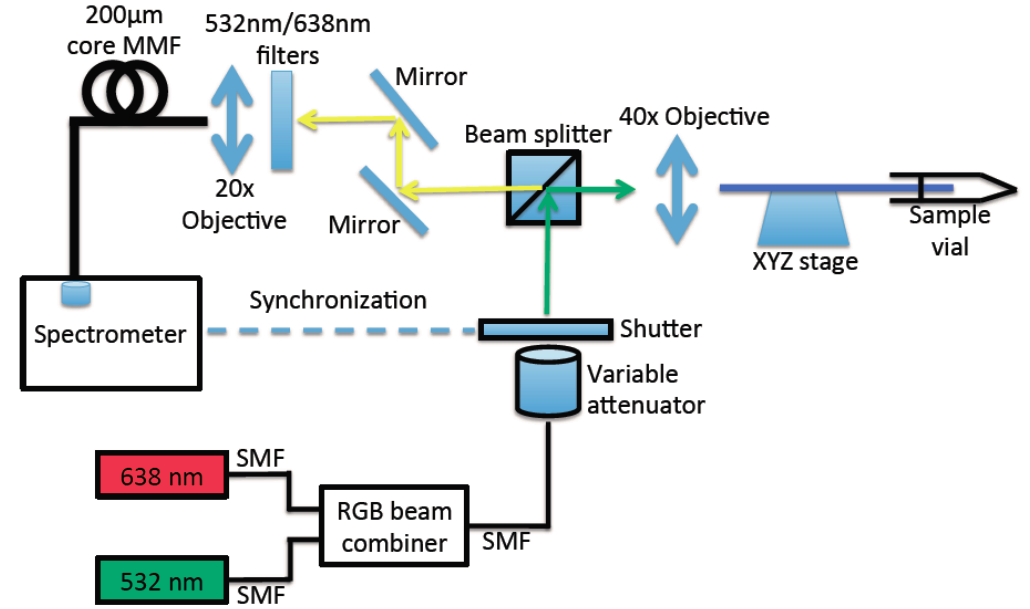
Figure 2. Experiment setup for fluorescence measurement of the dual-type molecular beacons (MBs) immobilized SCF filled with DNA solutions. SMF and MMF are abbreviations for single mode and multimode mode optical fiber, respectively. The green laser operating at 532 nm was used to excite HEX dyes (for wild-type sequence) and the red laser operating at 638 nm was used to excite Cy5 dyes (for mutant-type